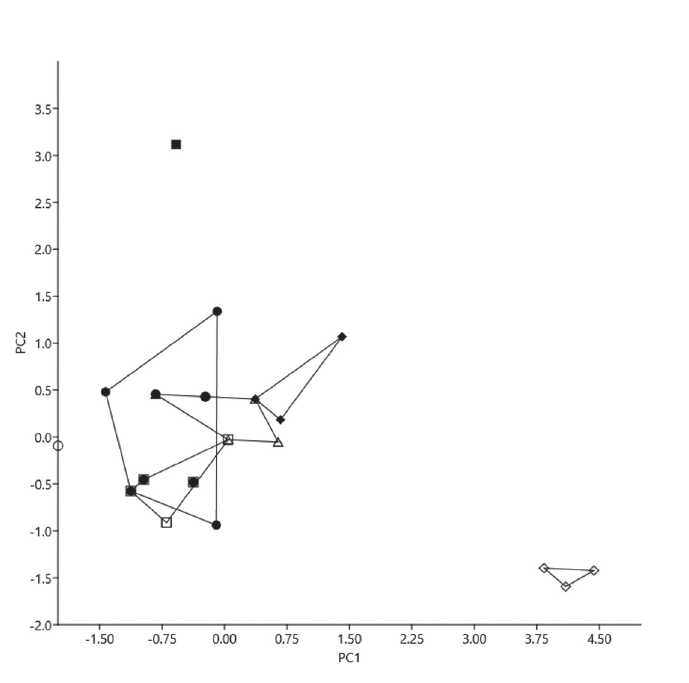
Fig. 5. Scatterplot of PC2 against PC1 for a PCA on 10 meristics (n = 36) of E. cf . miolepis specimens from the Lower Congo: Inkisi ( ◊ ), Luki 1 ( ♦ ) and Luki 2 ( ∆ ). Also shown are the type specimens examined of: E. miolepis (Boulenger, 1902) ( ○ ), E. holotaenia (Boulenger, 1904) (●), E. eutaenia (Boulenger, 1904) (□) and E. kerstenii (Peters, 1868) ( ■